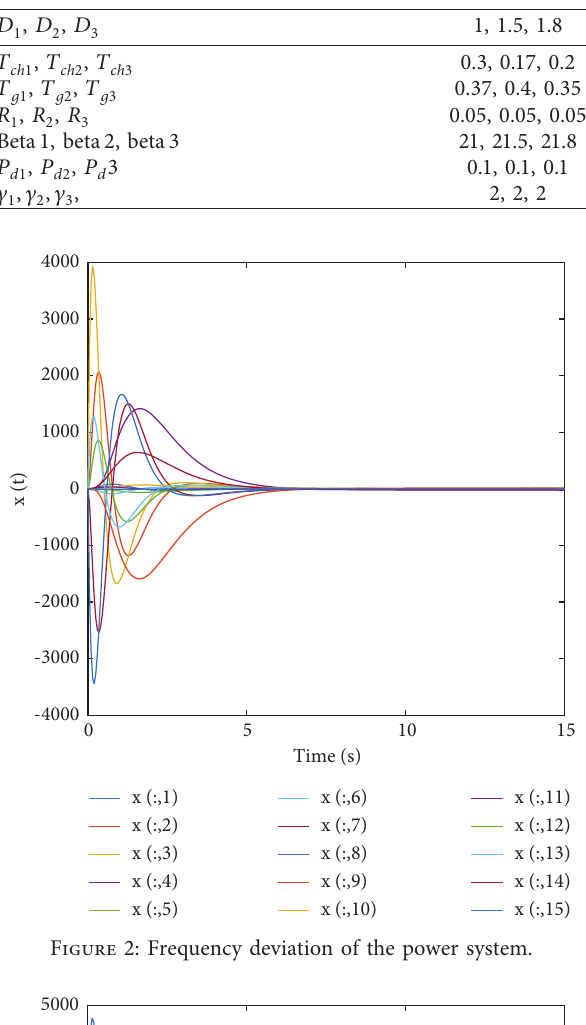
Table 2: Parameters of the three-area interconnected power system.